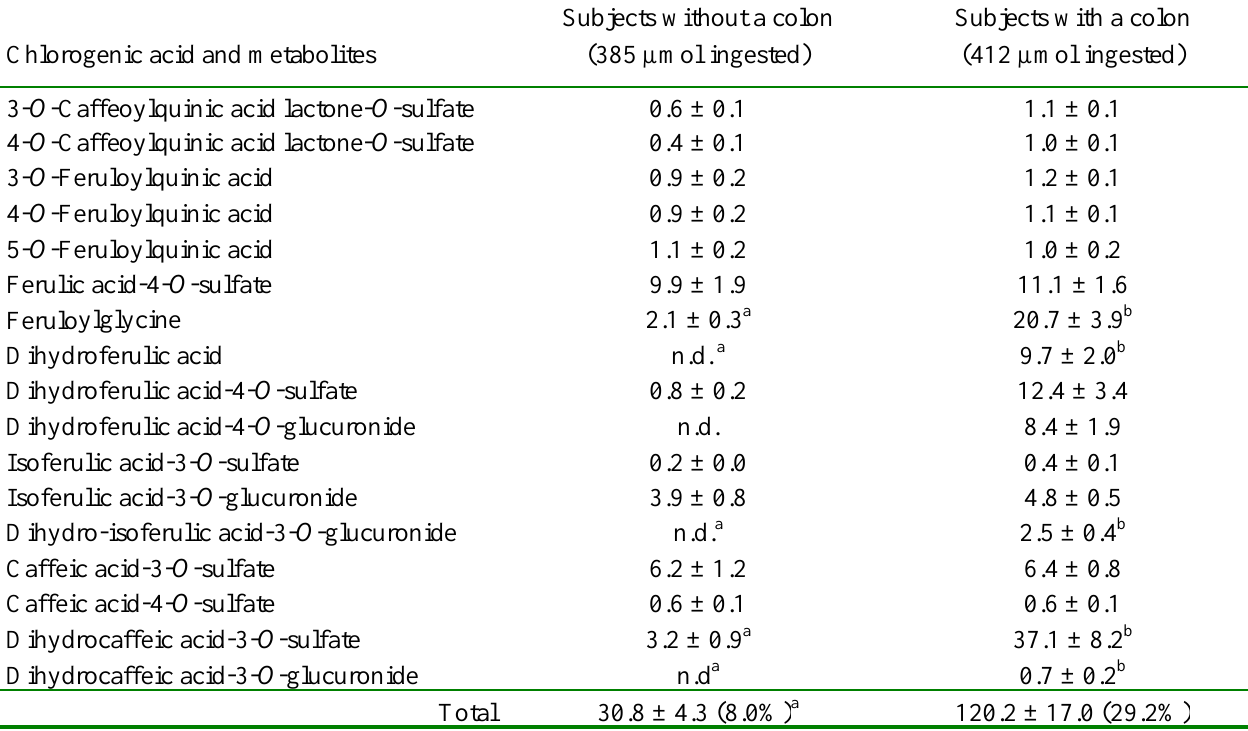
Table 1 . Urinary excretion of chlorogenic acid metabolites in 0–24 h urine of healthy subjects (n = 11) and ileostomists (n = 5) following the ingestion of 200 mL of